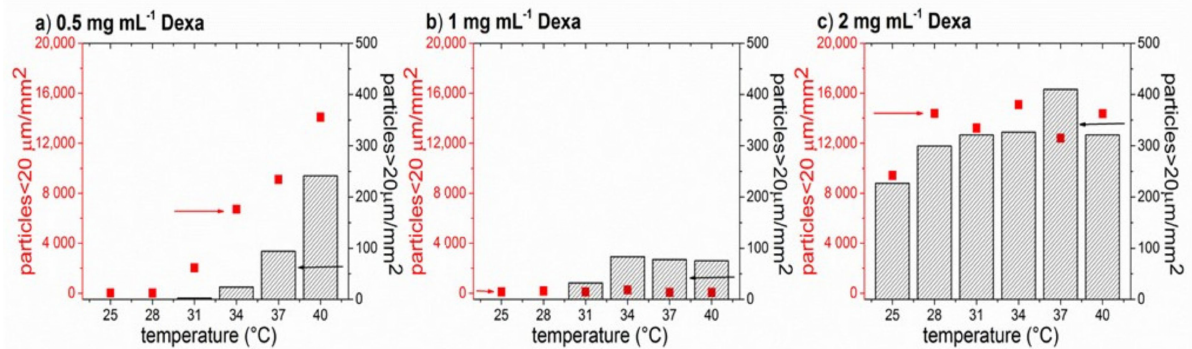
Figure 5. The temperature dependence of the number of smaller (squares) and larger (columns) microparticles formed from P1 copolymer (10 mg · mL − 1 ) and various concentrations of Dexa at 25 ◦ C and 37 ◦ C in PBS. The sample droplet was observed under an optical microscope with a heating plate. The images were evaluated using ImageJ software. The density of the particles is calculated from three different locations on the